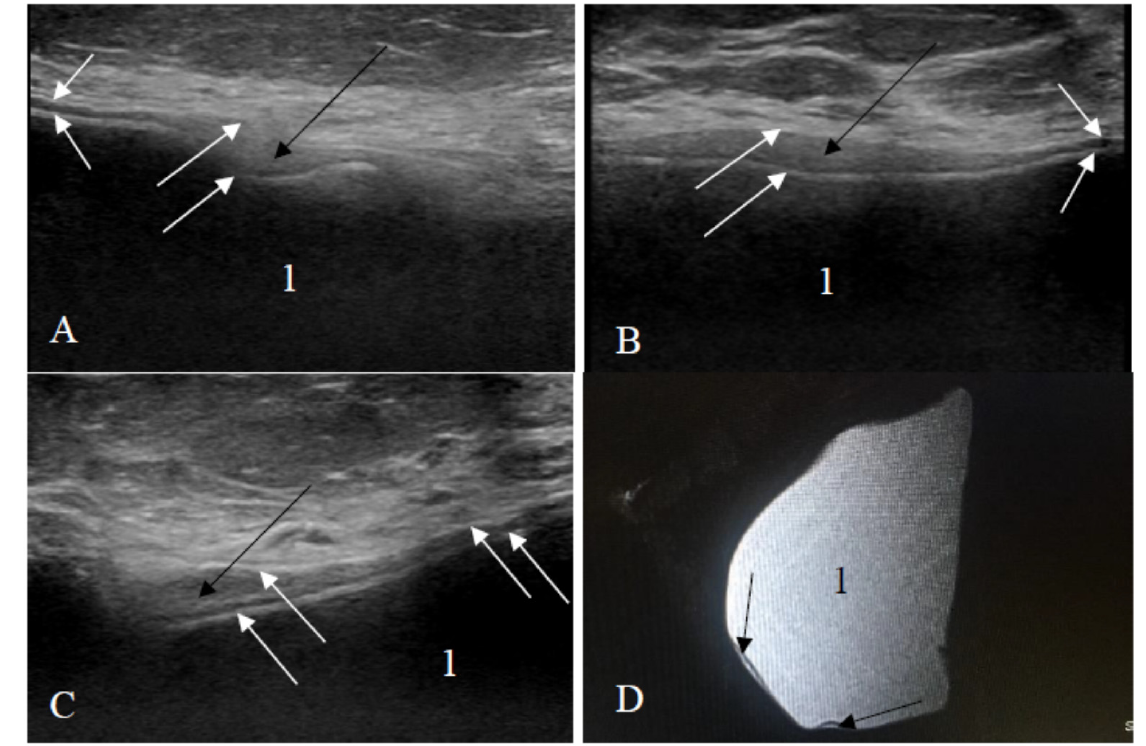
Figure 6. Ruptured implant (only one rupture sign visible): ( A – C ) ultrasound scans; ( D ) sagittal silicone-exited MRI sequence; white arrows—an uneven implant shell; black arrows—a small amount of silicone is outside the shell of the implant; 1—homogeneous content.